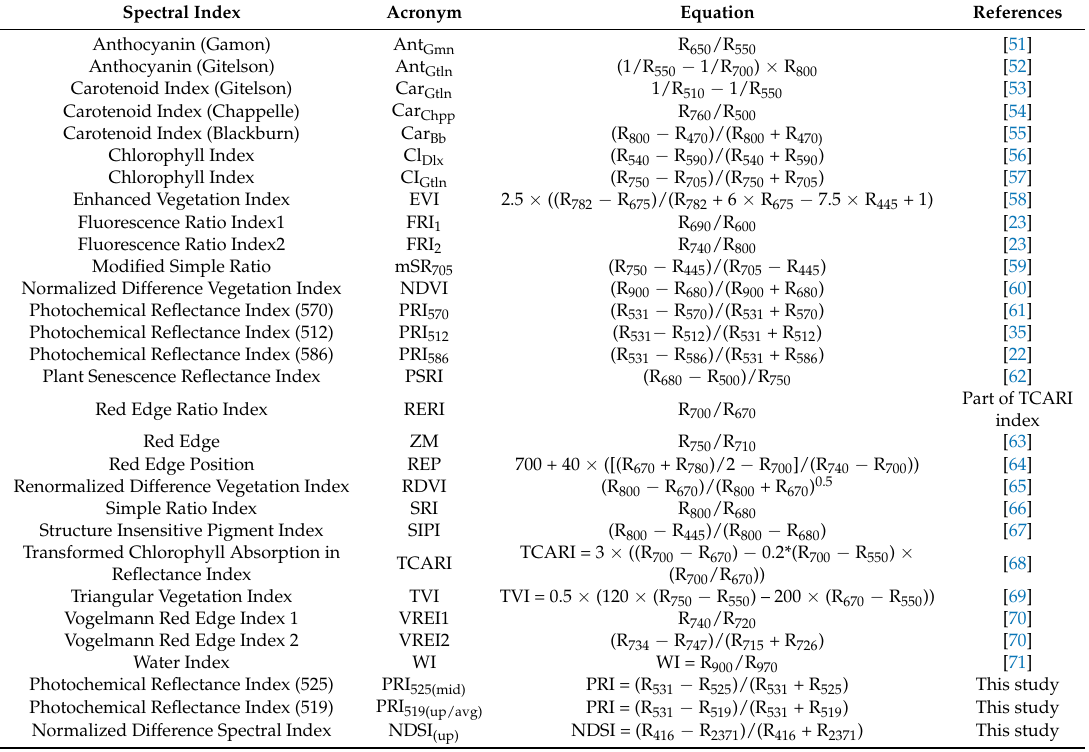
Table 2. Spectral indices used in this